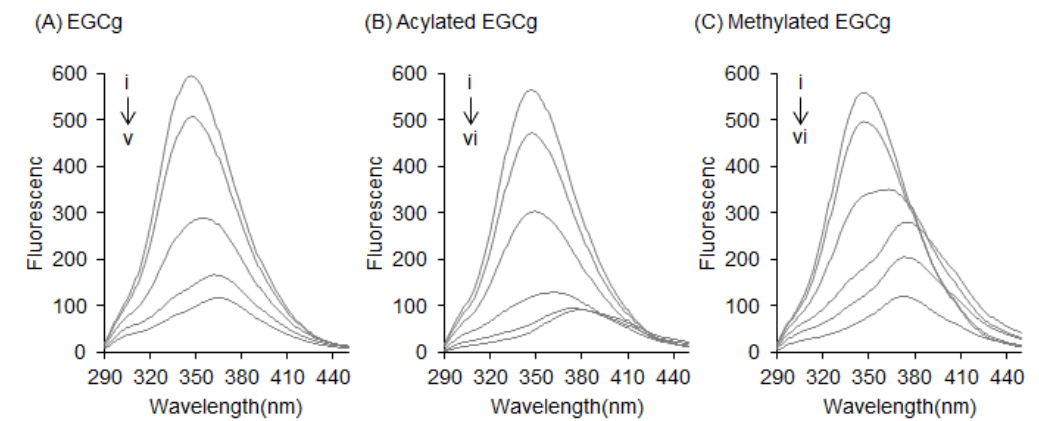
Figure 3. Effects of EGCg and its derivatives on the fluorescence of BSA. Fluorescence spectra of 0.3 mg/mL BSA with various concentrations of ( A ) EGCg, ( B ) acylated EGCg, and ( C ) methylated EGCg were measured at an excitation wavelength of 280 nm. Symbols i to vi show the spectra of BSA with increasing quencher concentrations of 0, 1, 5, 12.5, 25, and 50 μ M, respectively.